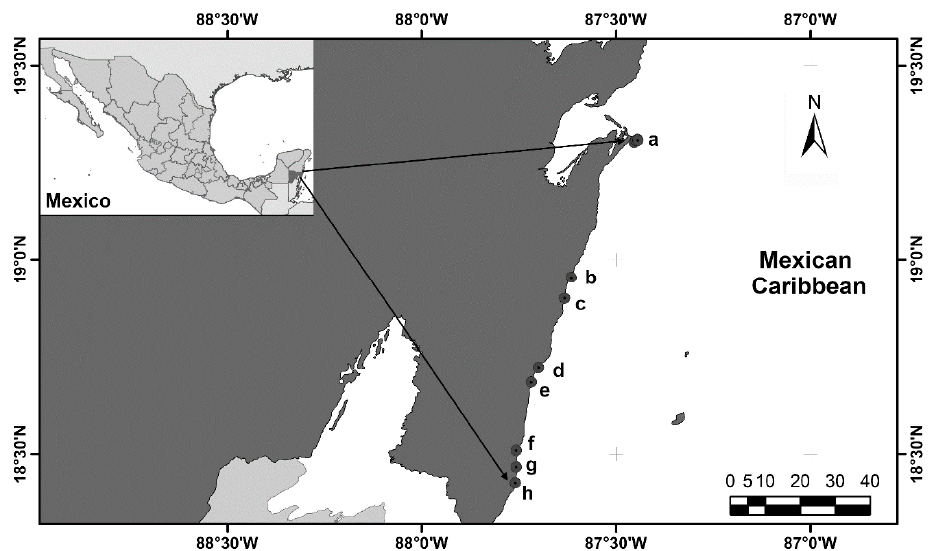
Figure 1. Localities within the Southern Mexican Caribbean where decapods were collected. (a) Punta Herrero; (b) Punta Diamante; (c) El Uvero; (d) Mahahual; (e) Bermejo River; (f) North of Xahuayxol; (g) Xahuayxol; (h) Huach River. Figure edited by Jani Jarquín-González. The PCR products were visualized in agarose gel Invitrogen TM with four µ L of sample and 16 µ L of water. The PCR products were sequenced at Macrogen (Seoul, Republic of Korea). Finally, the sequences were edited with Codon code v.3.0.1 and uploaded to BOLD. Specimen images, field data, and COI sequences obtained in this study can be con- sulted at BOLDSYSTEMS www.boldsystems.org within the dataset ID: DS-DECA01 De- capoda (Achelata and Brachyura) from Southern Mexican Caribbean ( https://doi.org/ 10.5883/DS-DECA01, accessed on 13 July 2022).